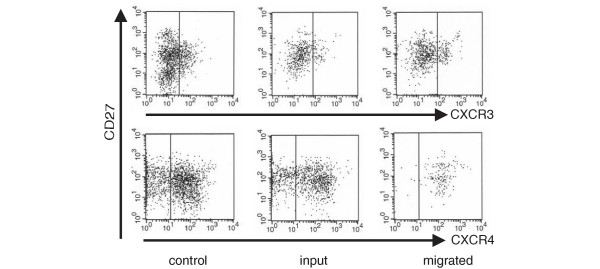
Chemokine receptor expression and B cell migration. Peripheral blood mononuclear cells were tested in a transmigration assay. A cytometric analysis showed CXCR3 (upper row) and CXCR4 (lower row) expression on CD19+ B cells before analysis (control), after 90 min incubation in medium without chemokines (input) and after migration towards the chemokines CXCL10 (upper row) or CXCL12 (lower row) respectively (migrated).